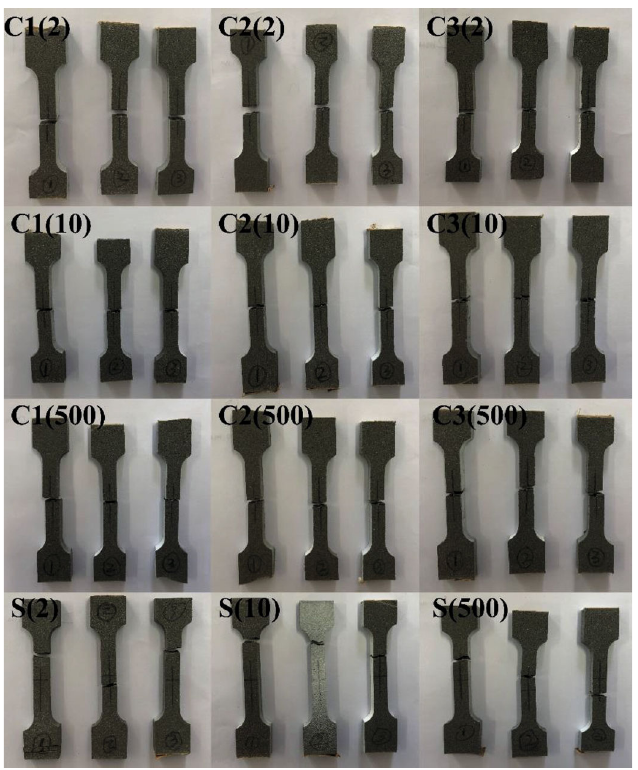
Figure 10: Overall shapes of the specimens after fracture.